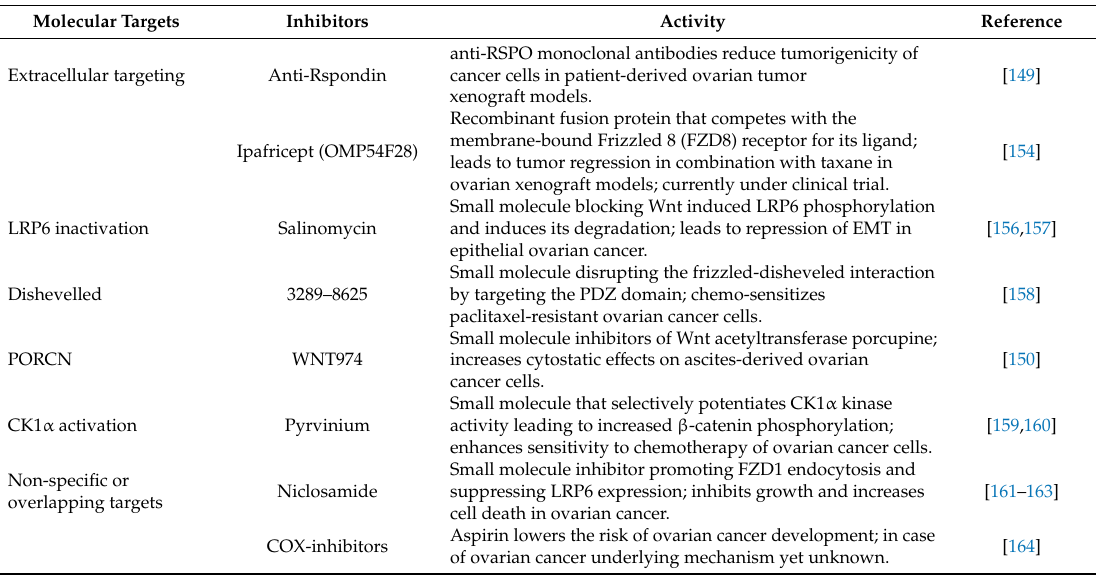
Table 2. Wnt inhibitors in ovarian